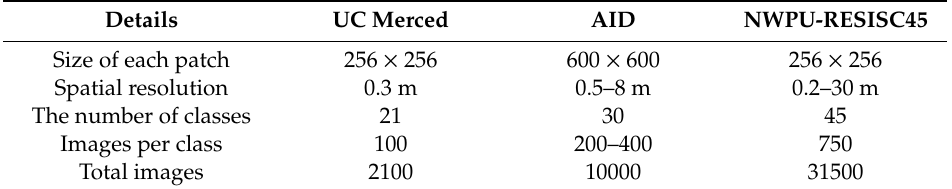
Table 1. Summarization of three datasets used in this paper.